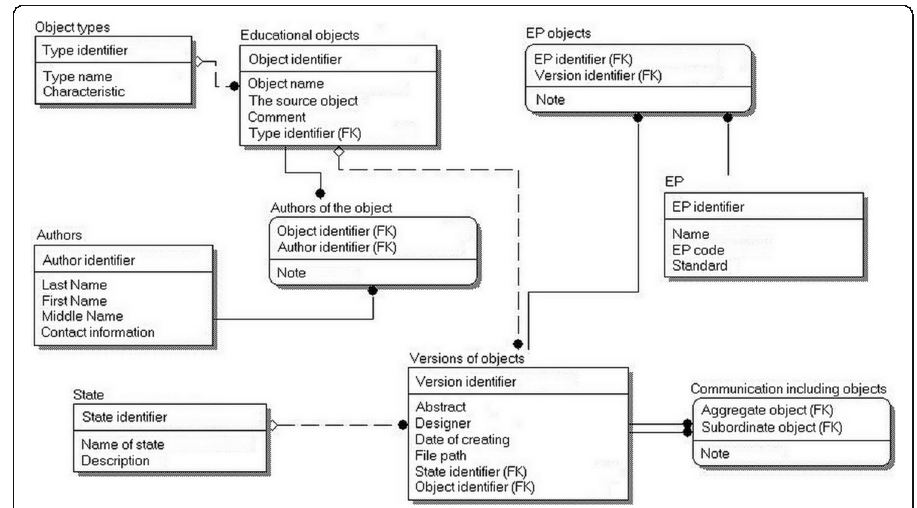
Fig. 5 Diagram of the storage data fragment